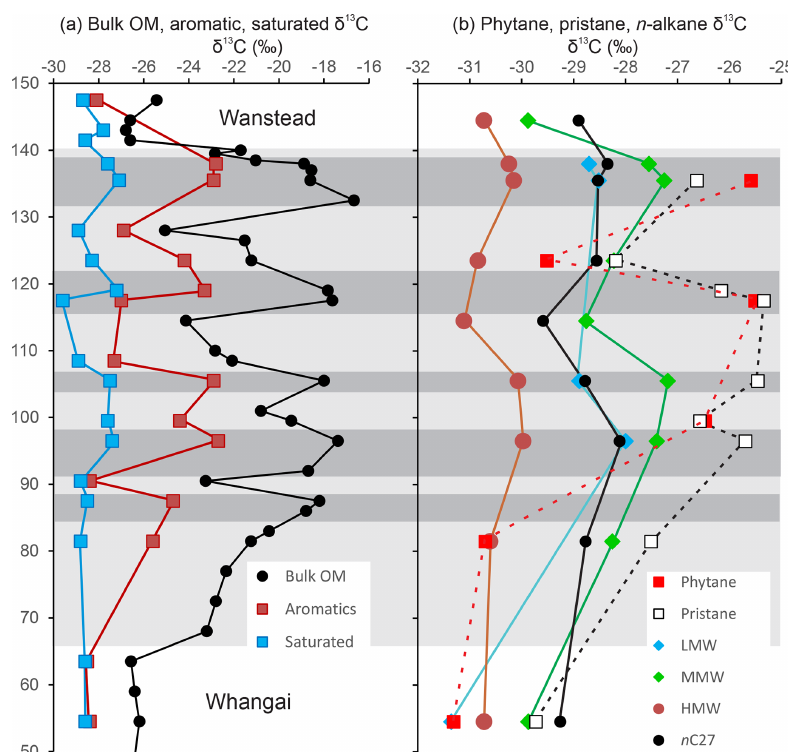
Figure 9. Stratigraphic and facies-related variation in (a) bulk organic, total aromatic, total saturated and (b) compound-specific δ 13 C values in the Taylor White section. Average values for odd-numbered LMW ( n C 19 ), MMW ( n C 21 – n C 25 ) and HMW ( n C 27 – n C 33 ) n -alkanes in addition to a representative HMW n -alkane ( n C 27 ). Horizontal bands represent OM-poor (pale grey) and OM-rich (medium grey) Waipawa